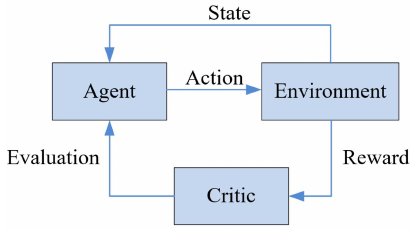
Figure 2. The basic framework of